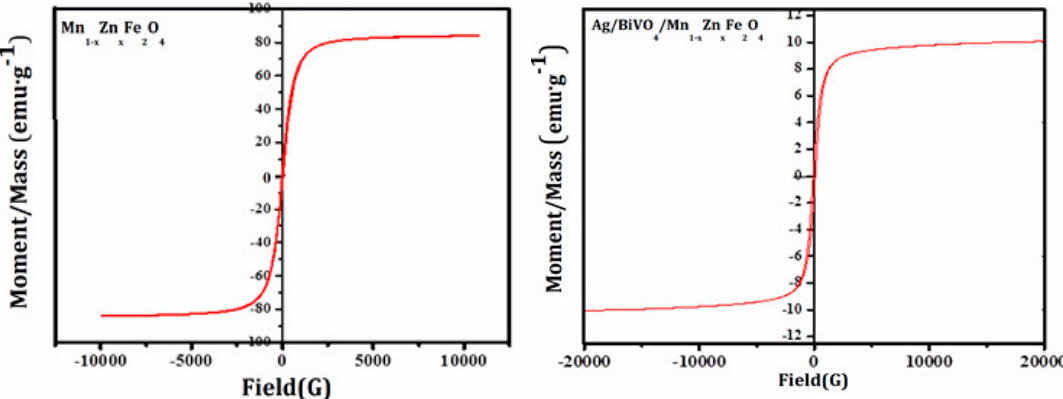
Figure 6. Hysteresis loops of BiVO 4 /Mn 1 − x Zn x Fe 2 O 4 and Ag/BiVO 4 /Mn 1 − x Zn x Fe 2 O 4 .